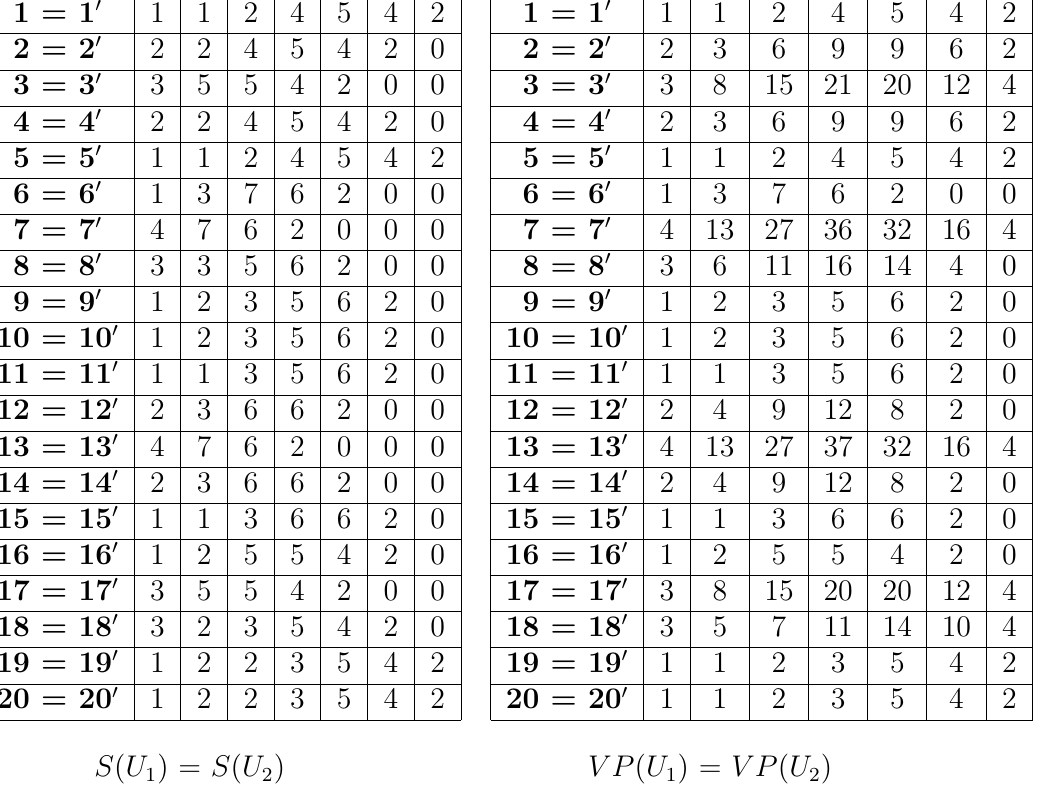
TABLE 3 : The Randi´c-table and the vertex path-table of the smallest pair of non-isomorphic trees in Figure